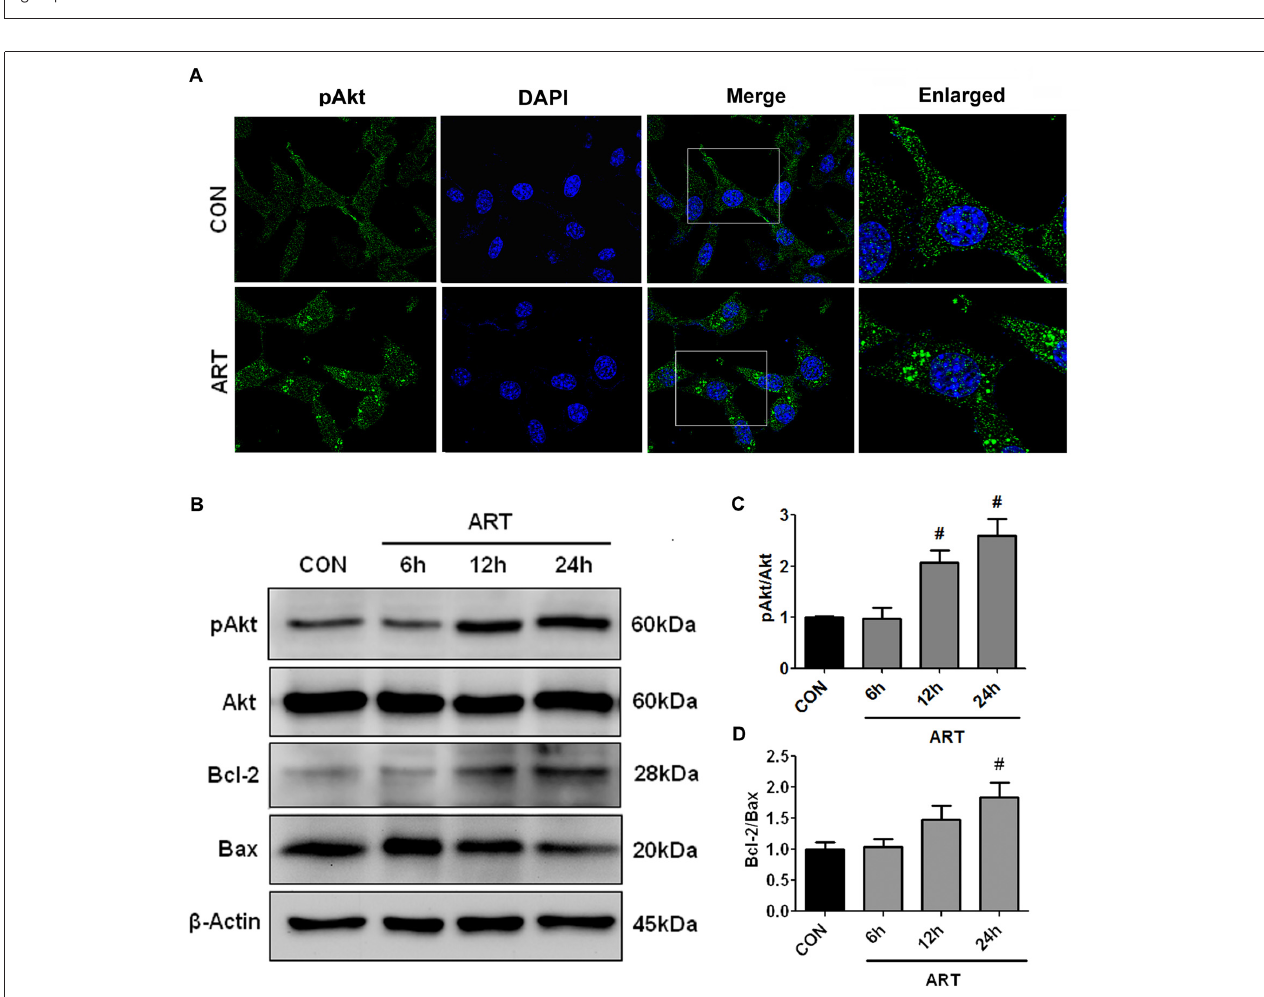
FIGURE 5 | Treatment with artemisinin activated Akt pathway in HT-22 cells. (A) Immunocytochemical staining of phosphor-Akt showed that treatment with artemisinin increased Akt phosphorylation. (B–D) Western blots demonstrated that artemisinin increased pAkt/Akt and Bcl-2/Bax ratio in a time-dependent manner. # p < 0.05 vs. CON